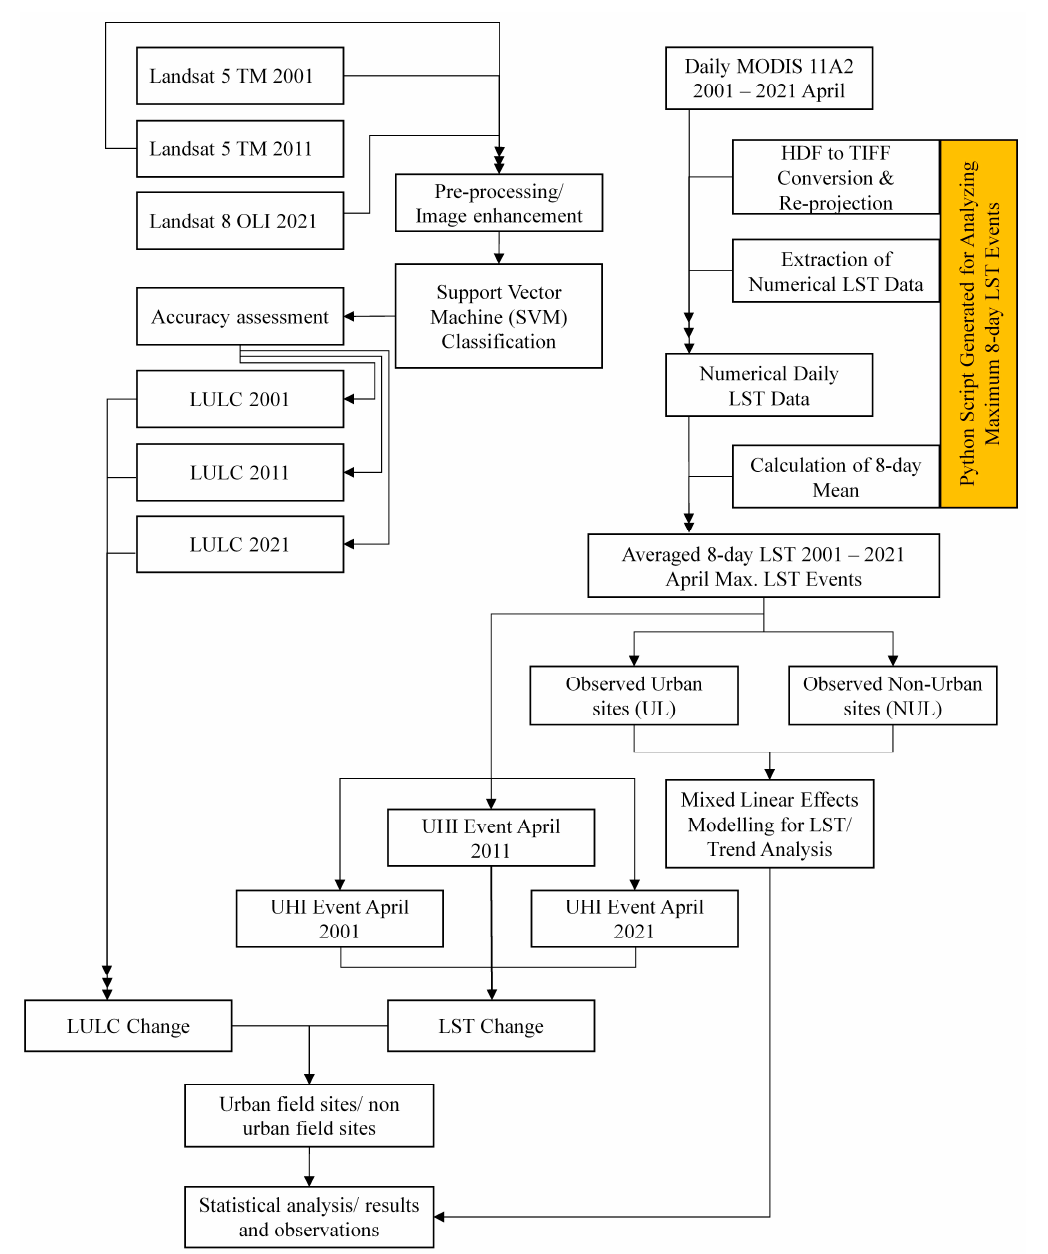
Figure 2. The overall methodology used in this study.